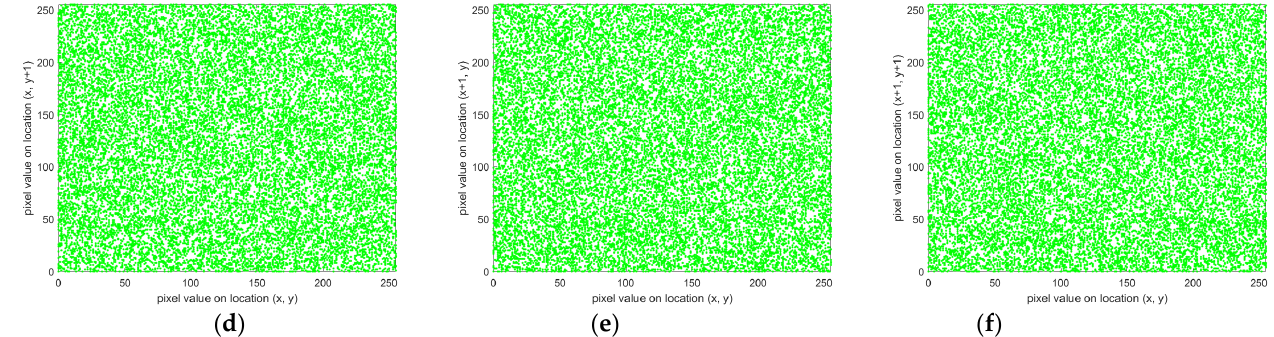
Figure 18. Green-component Adjacent pixel correlation of Baboon and corresponding cipher image: ( a ) Horizontal direction; ( b ) Vertical direction; ( c ) Diagonal direction; ( d ) Horizontal direction; ( e ) Vertical direction; ( f ) Diagonal direction.